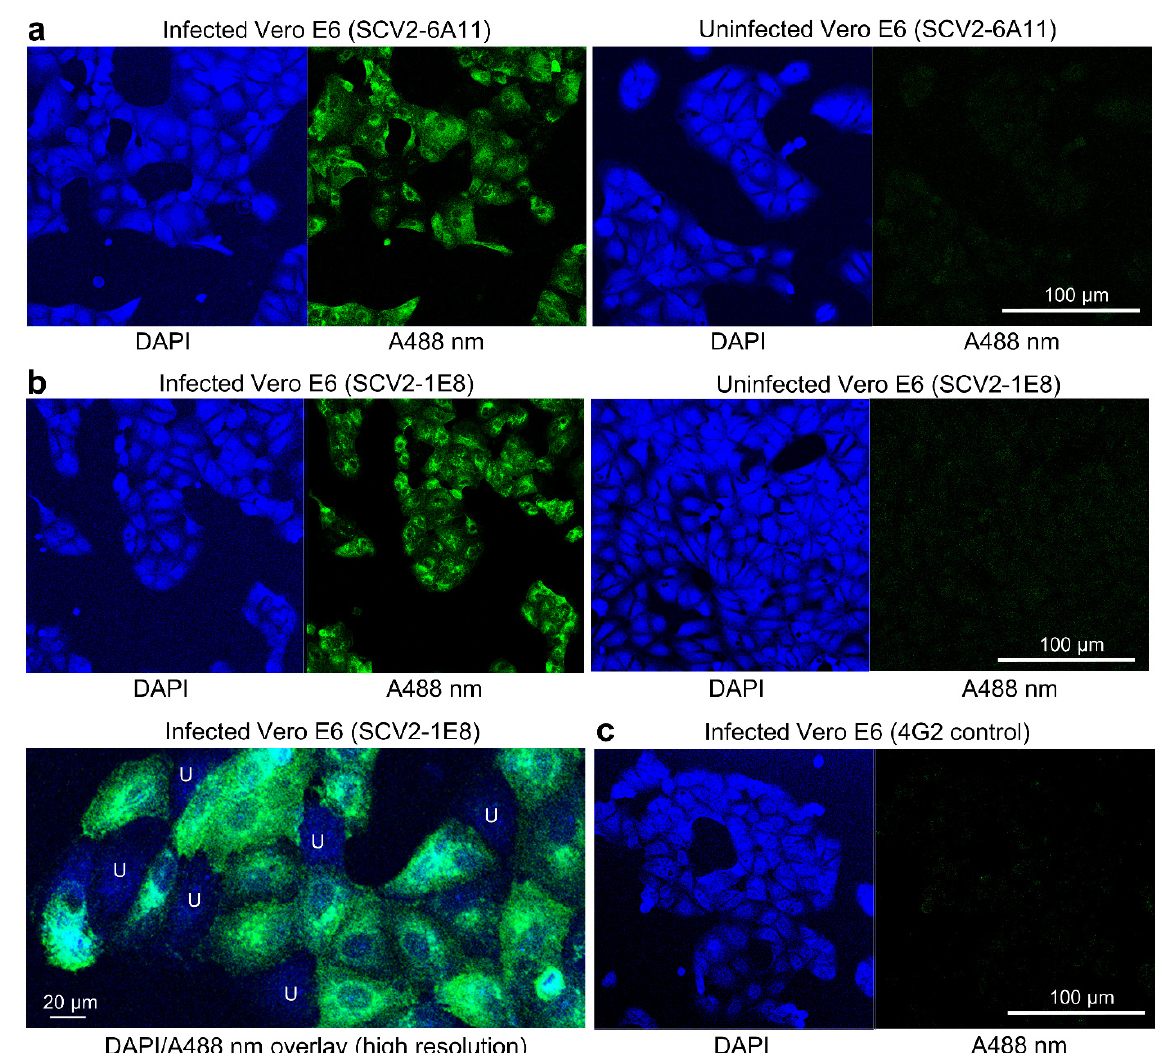
Figure 2. Indirect Immunofluorescence Assay (IFA) staining. ( a ) Vero E6 cells infected with SARS-CoV-2 QLD02 (left) or uninfected (right) stained with DAPI (blue) and anti-SARS-CoV-2 mAb, SCV2-6A11 (green, A488 nm). ( b ) As in a, but stained with SCV2-1E8. Bottom left shows a high resolution image with DAPI/A488 nm overlap, where infected cells (green) can clearly be distinguished from uninfected cells (blue, labelled U). ( c ) Vero E6 cells infected with SARS-CoV-2 QLD02 stained with a negative control mAb, 4G2.